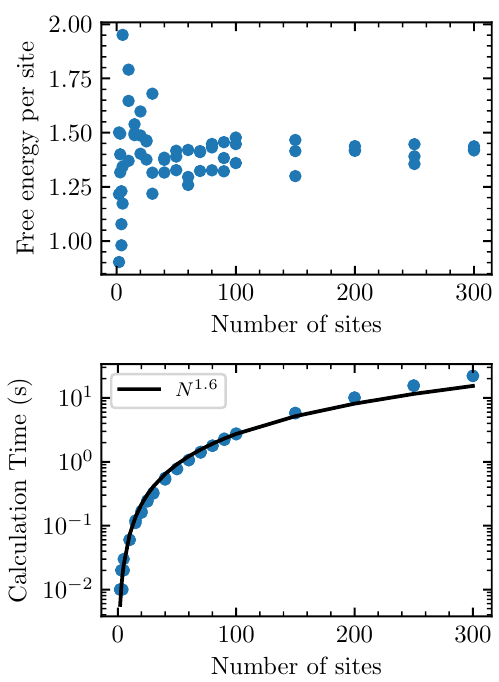
Figure 22: The free energy per site from PyTNR (top) and run time (bottom) for the 1D Ising model with disordered h and J is shown as a function of the number of sites. Note that three samples were drawn for each system configuration.